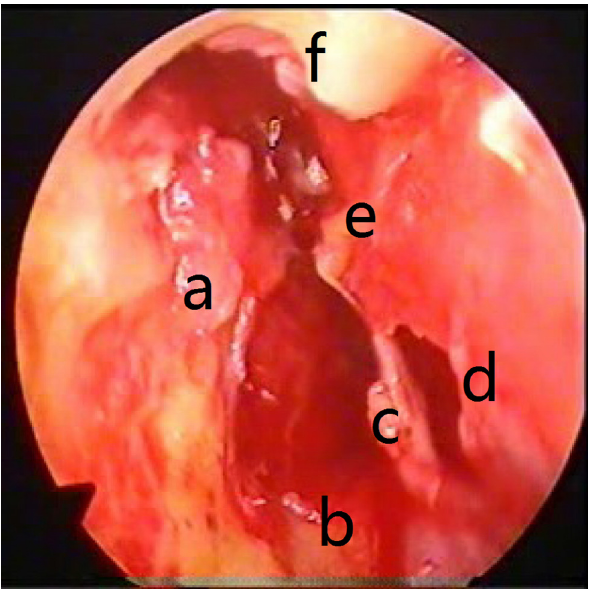
Fig 4. Preoperative middle ear endoscopic view: (a) Cholesteatoma and granulation tissue (around the stapes and facial recess); (b) Eustachian tube opening; (c) Hypotympanum; (d) Tympanic membrane perforation; (e) Malleus; (f) Scutum erosion.